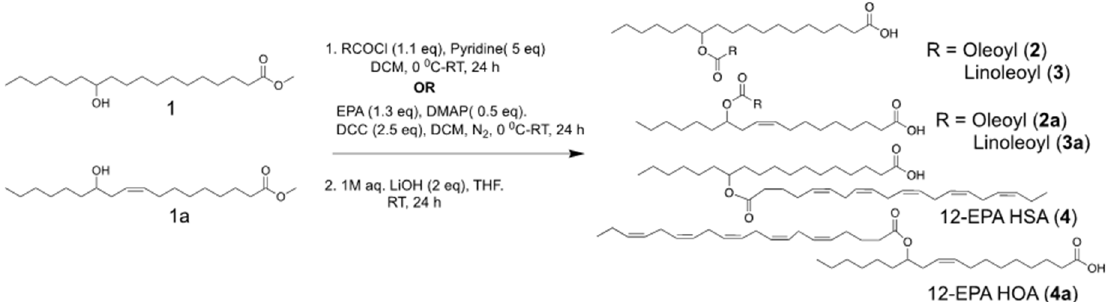
Scheme 1. Schematic representation of the chemical synthesis of fatty acid esters of hydroxy fatty acids (FAHFAs).